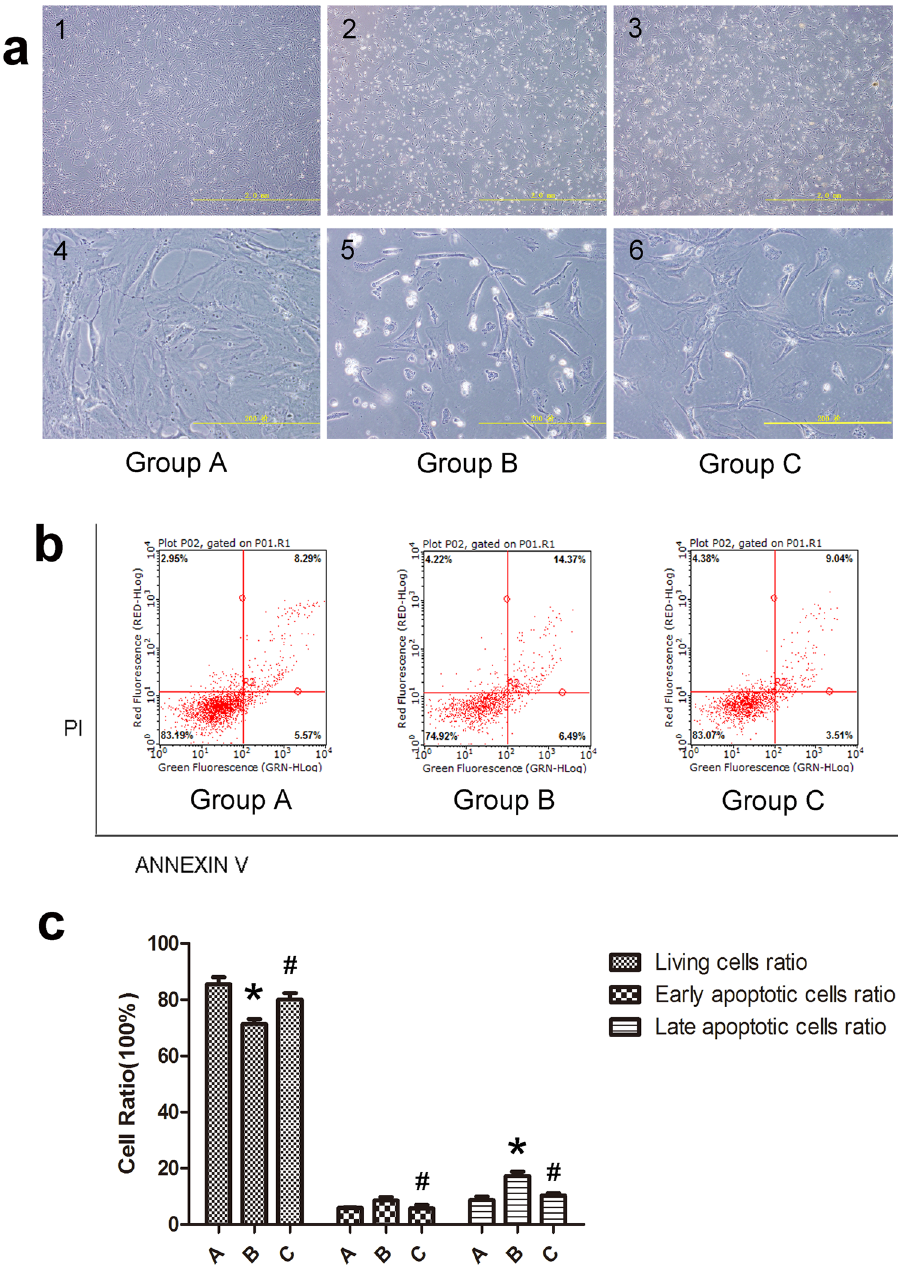
Figure 6. HuMSC-EXOs protect against cisplatin-induced injury of OGCs and promote resistance to cell apoptosis in vitro based on FACS. ( a ) Groups A, B and C were cultured for 48 h, and the number of apoptotic cells in group B was higher than that in group C under the microscope (a1–a3: × 40 magnification; a4–a6: × 400 magnification). ( b , c ) Through annexin-V-FITC/PI double staining and FACS analysis, the proportion of living cells between groups A and B was found to be different (P < 0.05). Similarly, the proportion of living cells in group B compared with group C was also different (P < 0.05). No significant difference (P > 0.05) in the percentage of early apoptotic cells between groups A and B was observed, whilst in groups B and C, a difference was observed (P < 0.05). For the percentage of late apoptotic cells, a difference was observed between group A and group B (P < 0.05), along with groups B and C (P < 0.05); n = 5. * Group B vs. group A. # Group C vs. group